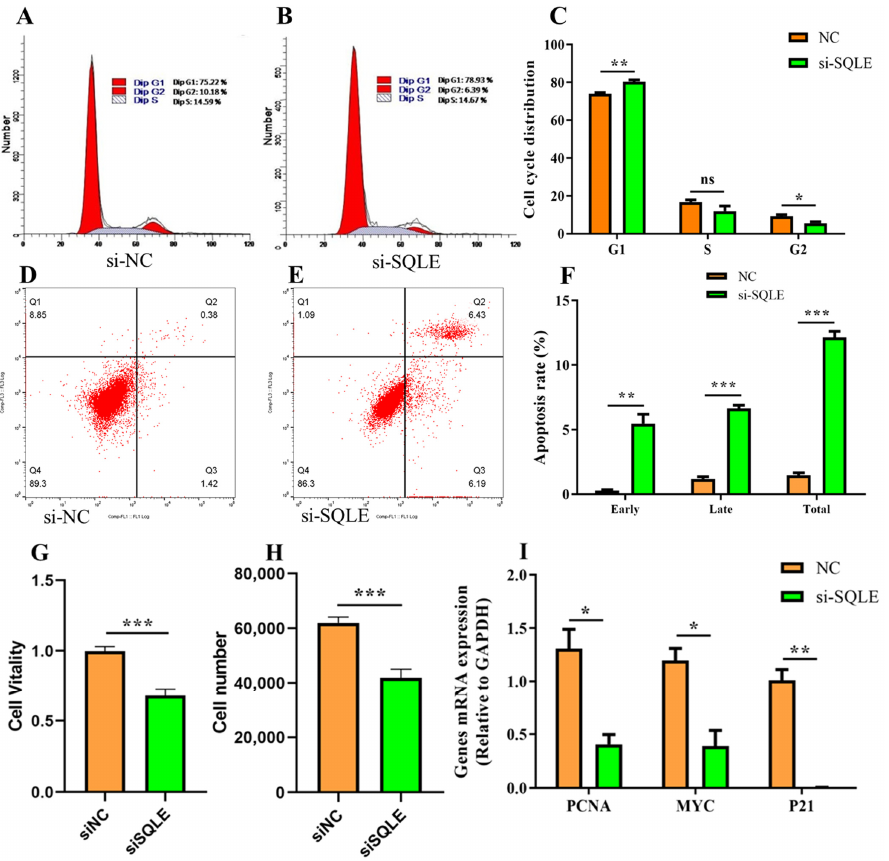
Figure 4. Effect of knockdown SQLE gene on BuMECs proliferation and apoptosis. ( A ) (si-NC) and ( B ) (si-SQLE) cell cycle distribution; ( C ) flow cytometry was used to detect cell cycle progression; ( D ) (si-NC) and ( E ) (si-SQLE) cell apoptosis distribution; ( F ) the rates of early, late, and total apoptosis were assessed. ( G ) The CCK-8 assay showed that SQLE knockdown resulted in a signif- icant decrease in cell viability; ( H ) the cell counting test showed that BuMECs were significantly decreased after SQLE knockdown; ( I ) mRNA expression of cell cycle, proliferation, and apoptosis– related genes. n = 3 biological replicates. * p < 0.05, ** p < 0.01, *** p < 0.001, ns: nonsignificant dif- ference, compared with control group. Error bars represent SEM.